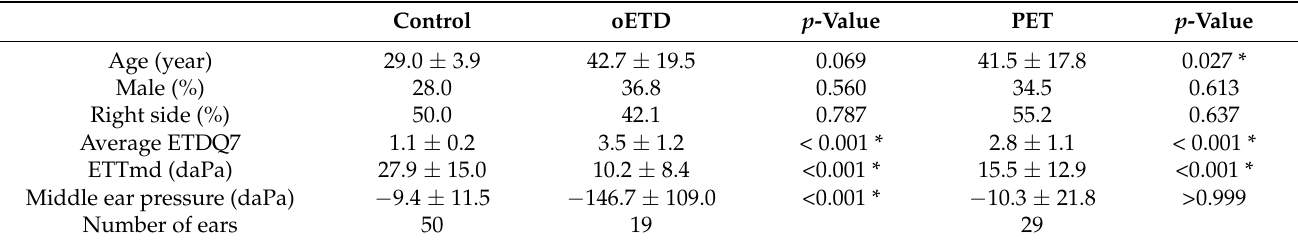
Table 1. Demographic data of enrolled subjects.